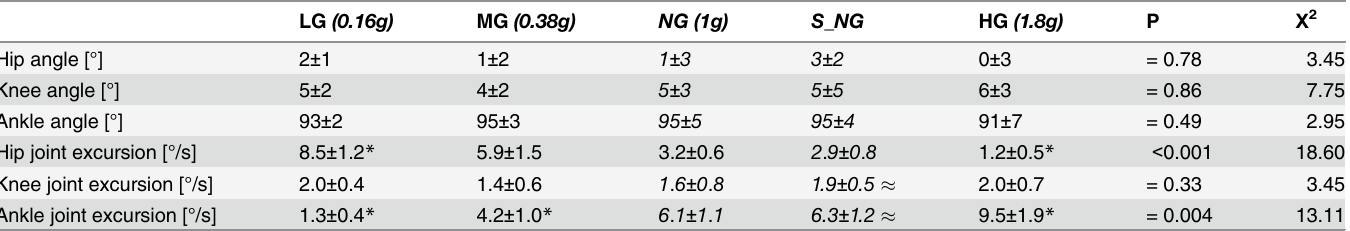
* indicates signi fi cant differences (p < 0.05) compared to NG. (cid:3) indicates statistical equivalence for simulated normal gravity (S_NG) compared to NG. P and Χ 2 values in the right columns display Friedman ANOVA